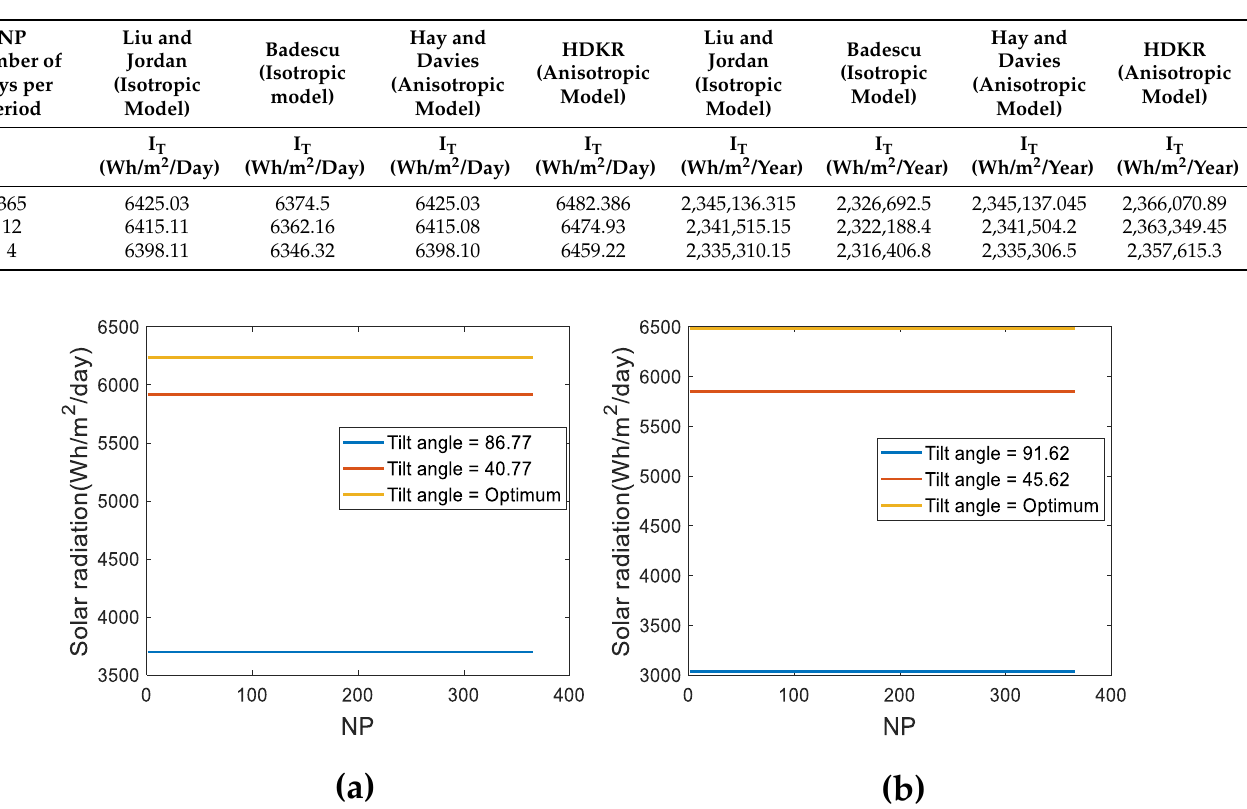
Table 11. Results comparison for Makkah city.